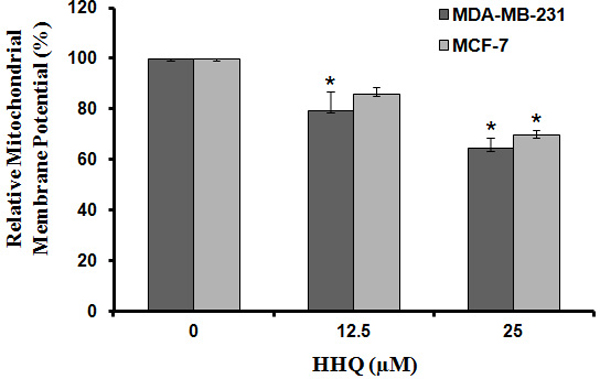
HHQ induced loss in mitochondrial membrane potential (MMP) in human breast cancer cells (MDA-MB-231 and MCF-7). The breast cancer cells were treated with 12.5 μM and 25 μM of HHQ for 48 h at 37 °C and then immunostained for JC1. HHQ treated cells showed loss of MMP comparable to that of the control cells. Data are representative of three independent experiments done in triplicates and expressed as mean ± S.E.M. *p < 0.005 represents statistical significant difference between control and HHQ test groups.